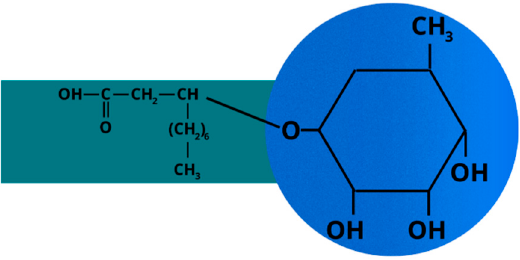
Figure 2. Structure of rhamnolipid biosurfactant with hydrophobic tail (green) and hydrophilic head (blue).